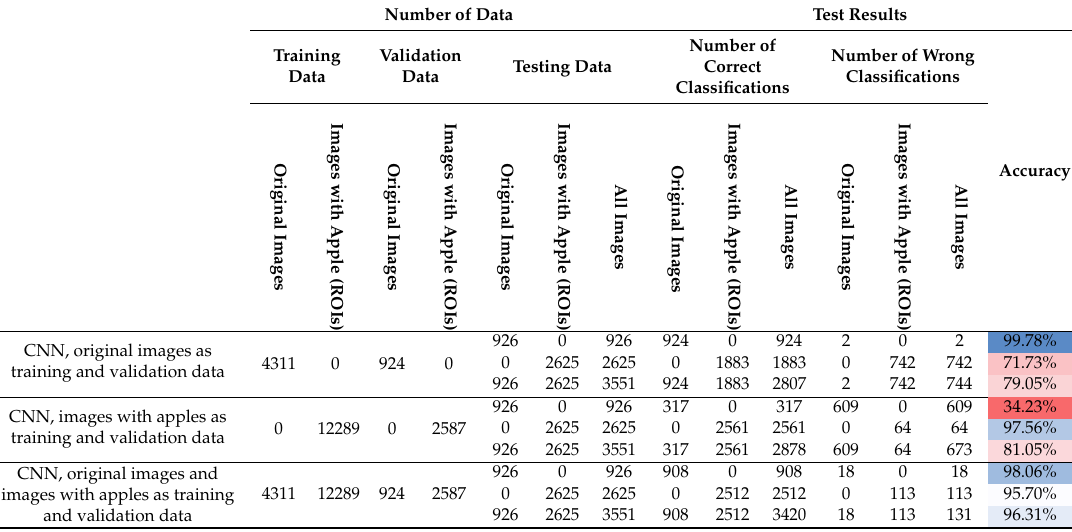
Table 4. Test results of CNNs trained with various training and validation